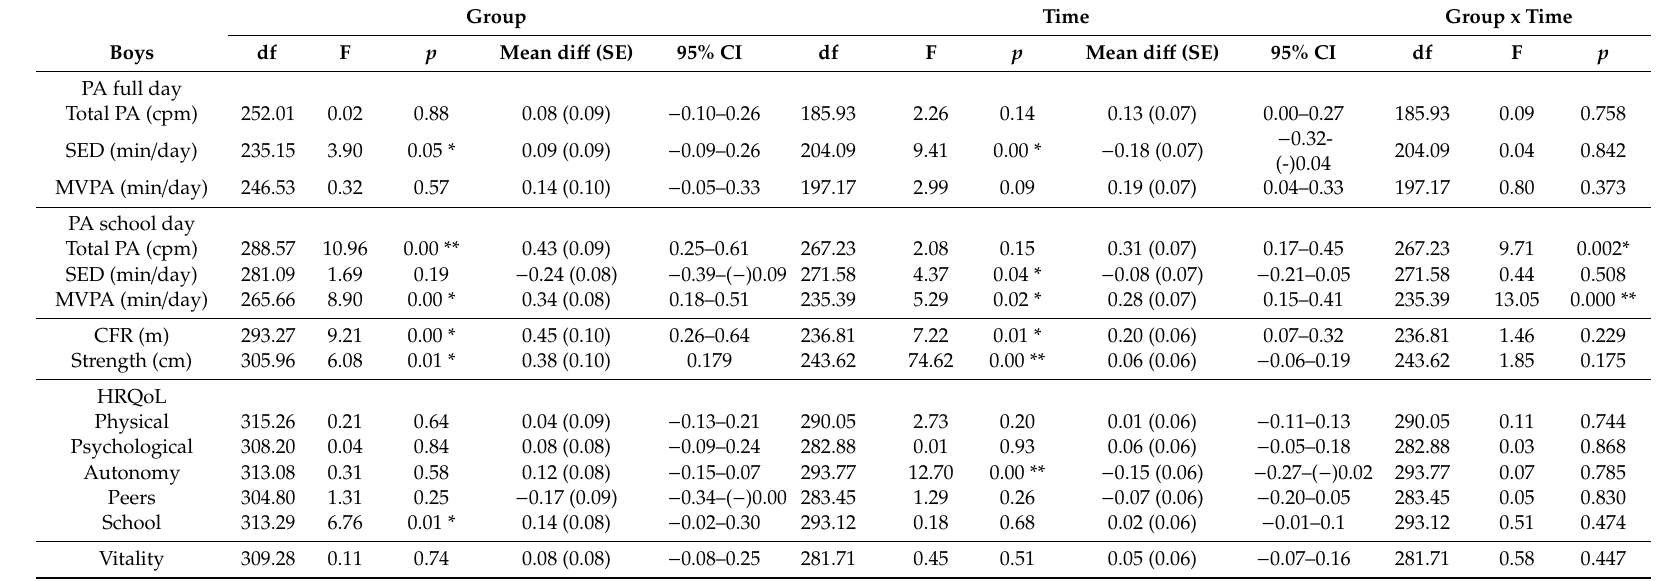
Table 5. E ff ects for